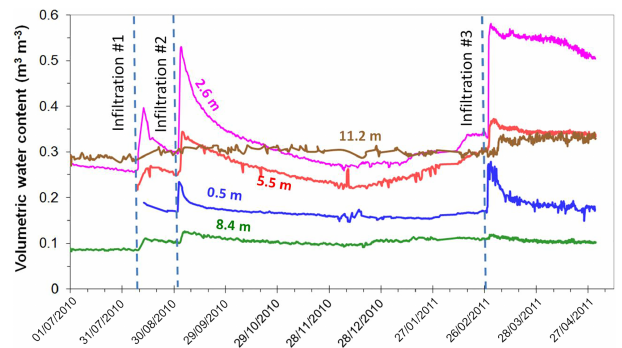
Figure 3. Temporal variations in sediment water content in the top 13m of the vadose zone during the infiltration experiments. Dates are given as